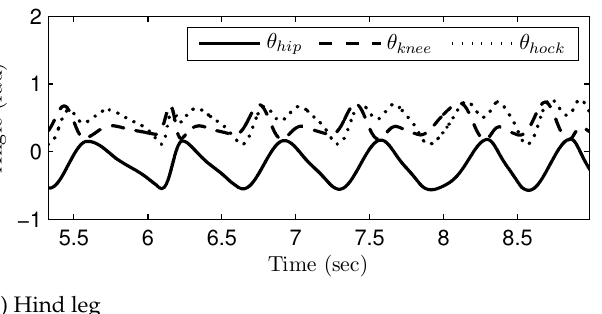
Figure 16. The join-angle trajectories when the gait phase is changed from the walk to canter: ( a ) front leg and ( b ) hind leg.